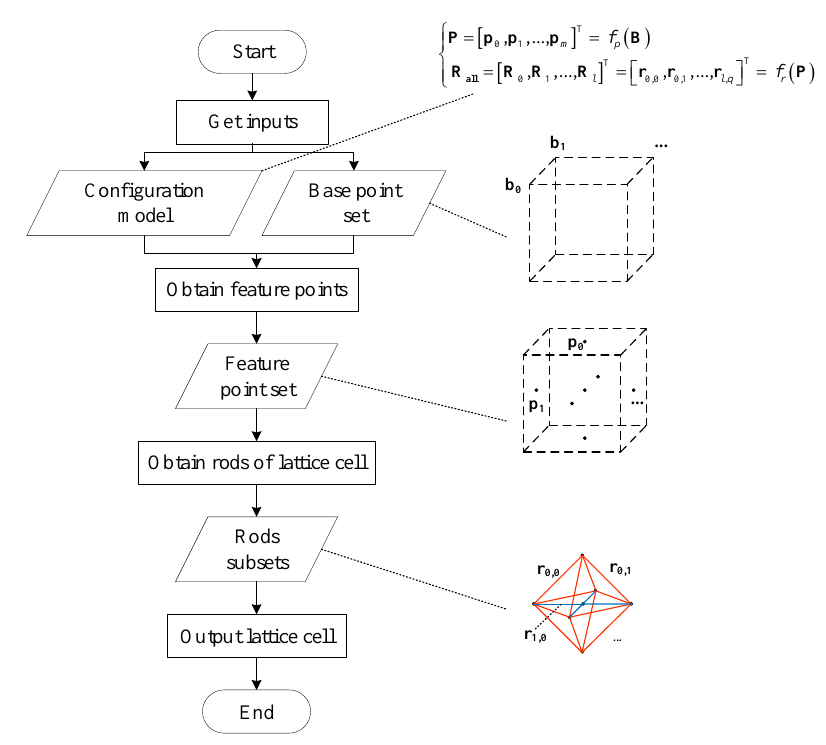
Figure 9. The process of the lattice cell structure design method.